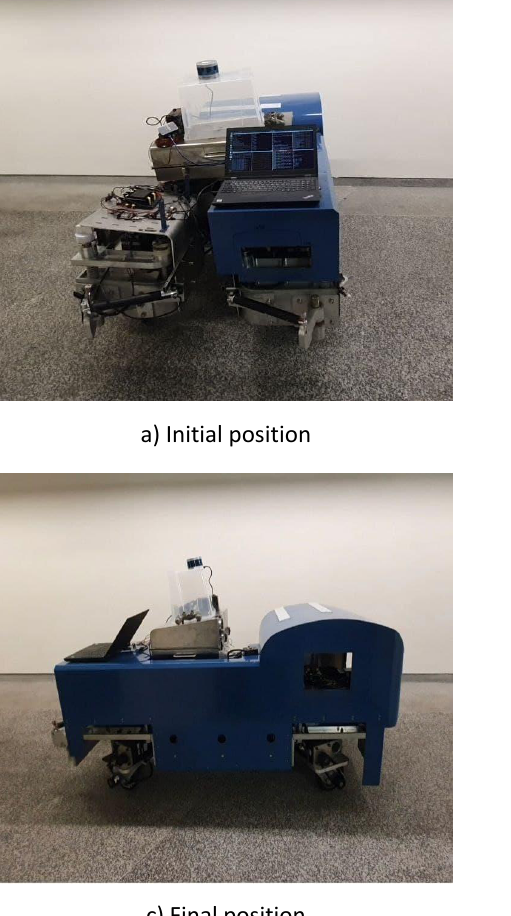
Figure 11. Rotation in a wide pavement depicting Scenario S3 (Figure